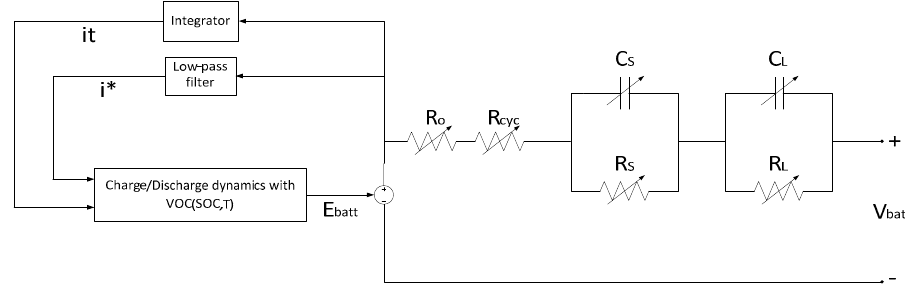
Figure 11. The proposed synthesized battery model.